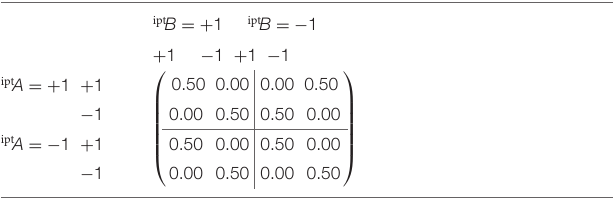
TABLE 3 | Pair-Wise joint distributions of two individual experimental trials. (a) Pair-wise joint distributions of individual experimental trial 1